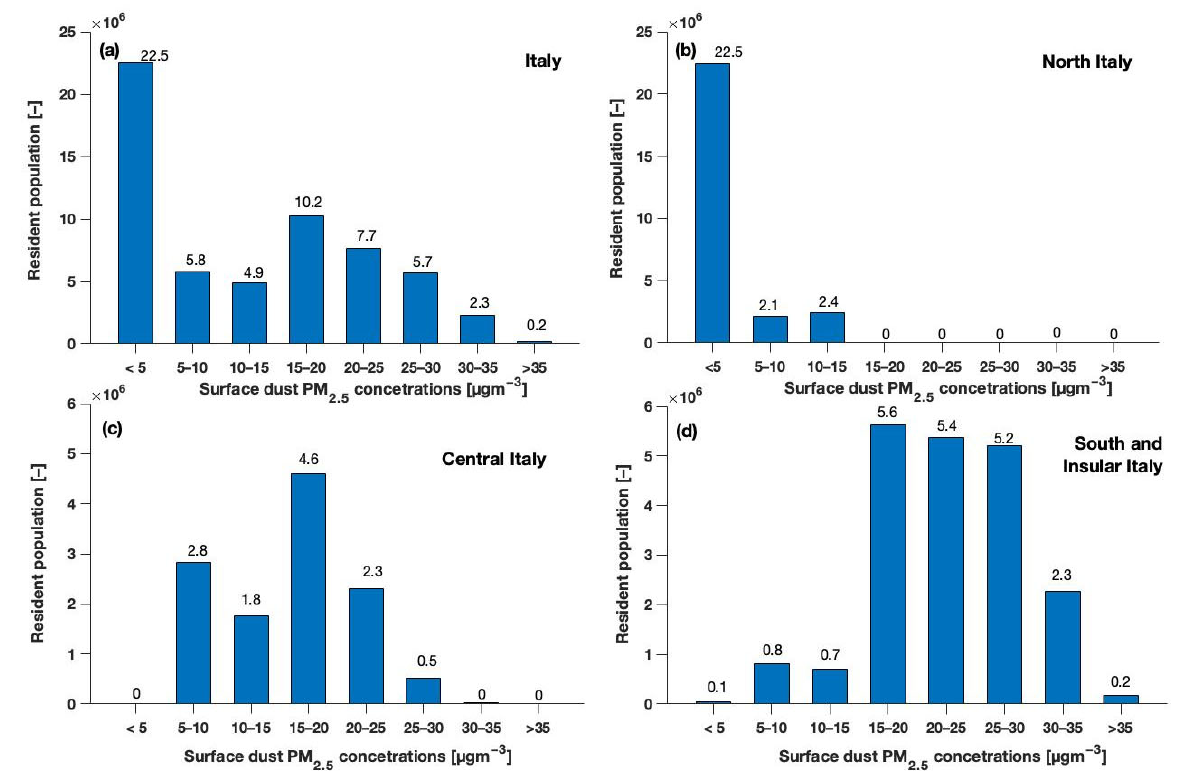
Figure 5. Classes of exposure to the full period (17–24 June) averaged surface dust PM2.5 mass concentrations simulated with WRF-Chem for the resident population in ( a ) Italy, and in the Italian macro-regions, namely ( b ) north, ( c ) central, and ( d ) south and insular Italy. At the national level, during the sequence of dust events, the highest percentage (38%) of resident population was exposed to averaged PM2.5 concentrations up to 5 µg